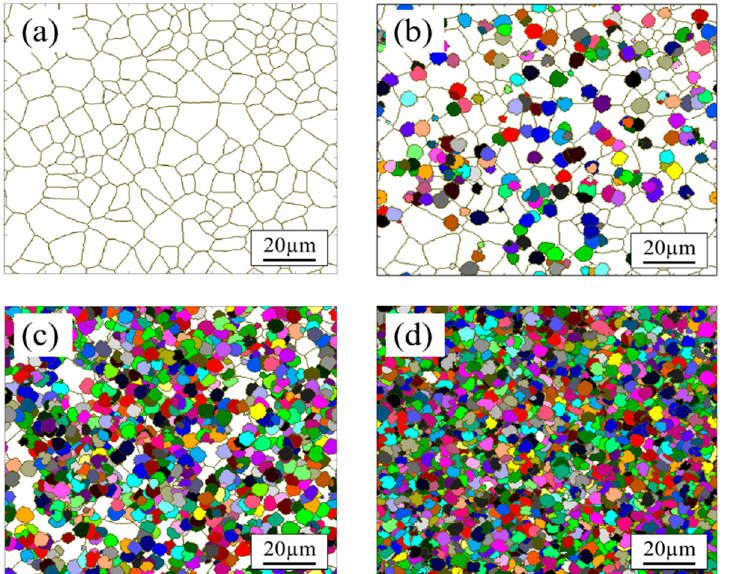
Figure 8. Microstructural evolution under different strains of ( a ) 0.1, ( b ) 0.2, ( c ) 0.5 and ( d ) 0.9 in CA simulation.